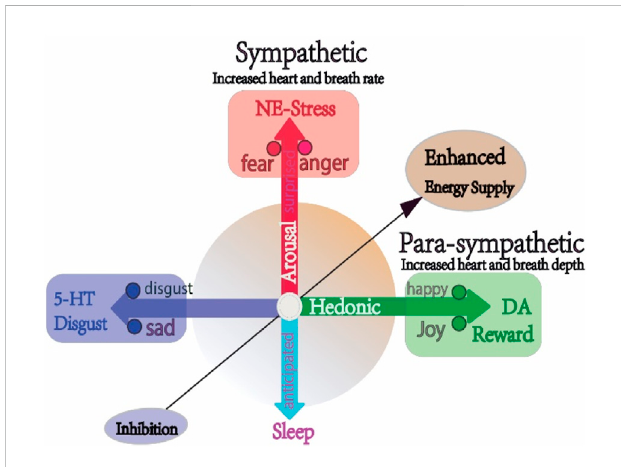
FIGURE 1 The three monoamines and three primary emotions and energy